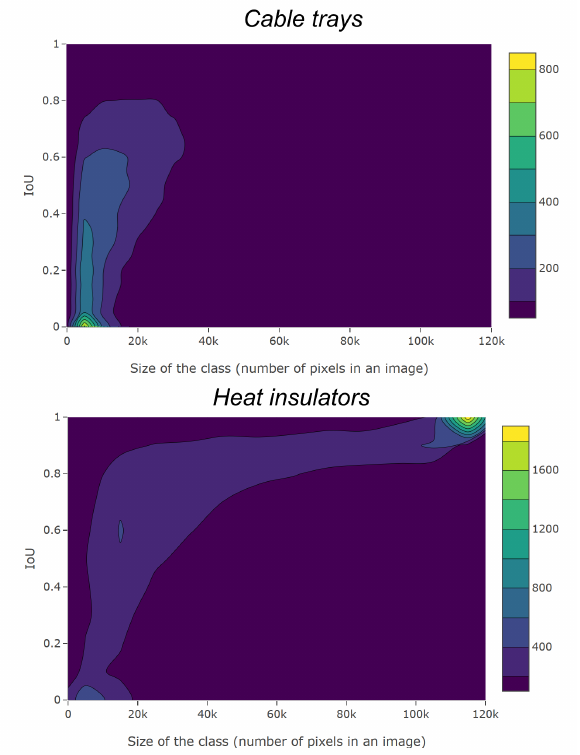
Figure 11. 2D density plot of stuff objects. Top: Heat Insulators. Bottom: Cable